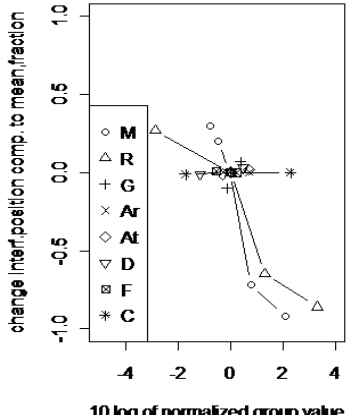
Fig. AI.2: Relations based on Eq. (AII1) between the mobile fraction ( ), average net precipitation 〈 〉 and aggregate diffusivity for a given aggregate radius ( of 10 -2 m (a) and with aggregate radius ( for a given aggregate diffusivity ( ) of 10 -9 m 2 s -1 (b), leading to an effective dispersivity ( ) of 0.1 m. Figures: